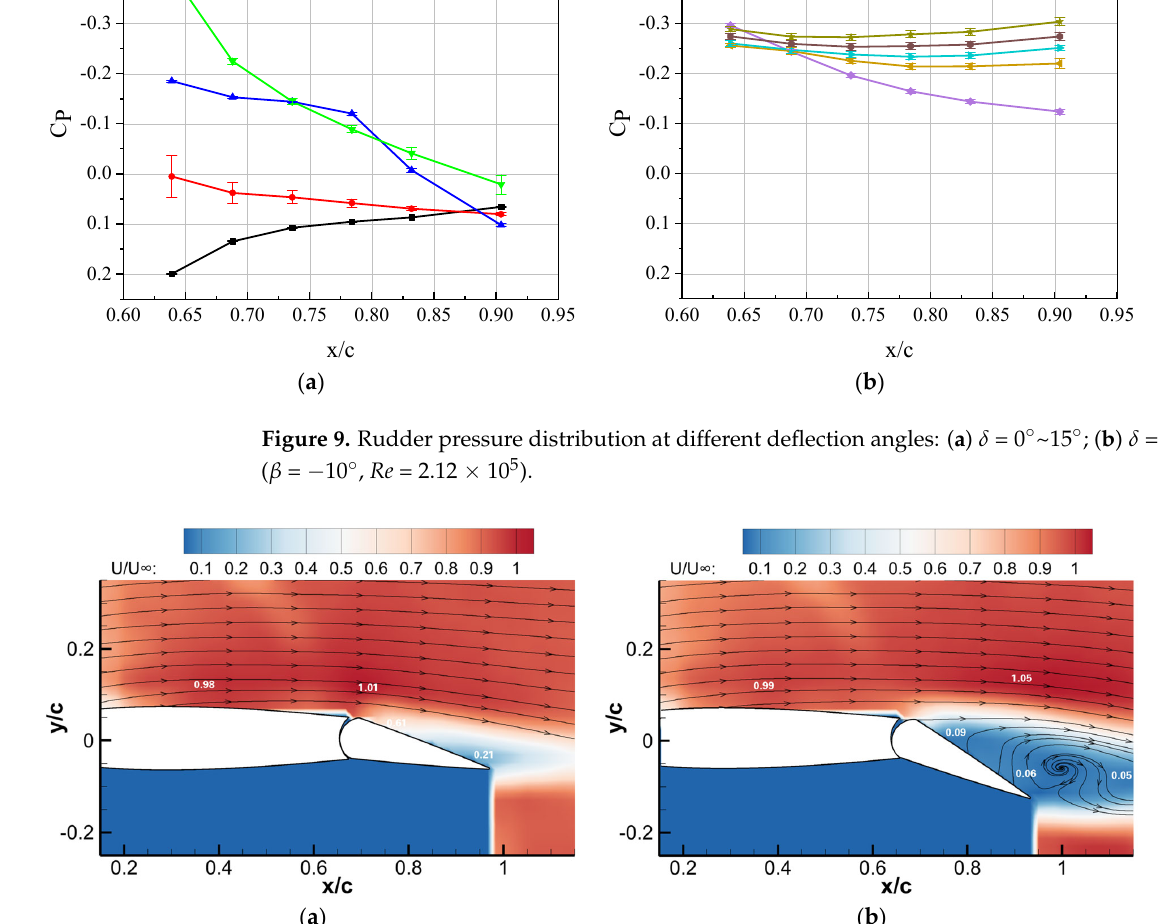
( b ) Figure 11. Velocity cloud diagram and streamline diagram of vertical tail upper surface without control: ( a ) δ = 15°; ( b ) δ = 30° ( β = − 10°, Re = 2.12 × 10 5 ). 3.3. Study on Flow Control of Vertical Tail under Different Momentum Coefficients First, the gain of three gradually increasing momentum coefficients on the vertical tail lateral force coefficient is studied. Since the jet’s direction is perpendicular to the di ‐ rection of the vertical tail’s lateral force, the jet does not directly increase the vertical tail’s lateral force. Figure 12 shows that when β = 0° and Re = 2.12 × 10 5 , the vertical tail model lateral force coefficient and lateral force coefficient increment under different momentum coefficient controls. After the oscillating jet flow control is applied to the vertical tail model, the lateral force coefficient is significantly increased, and the lateral force